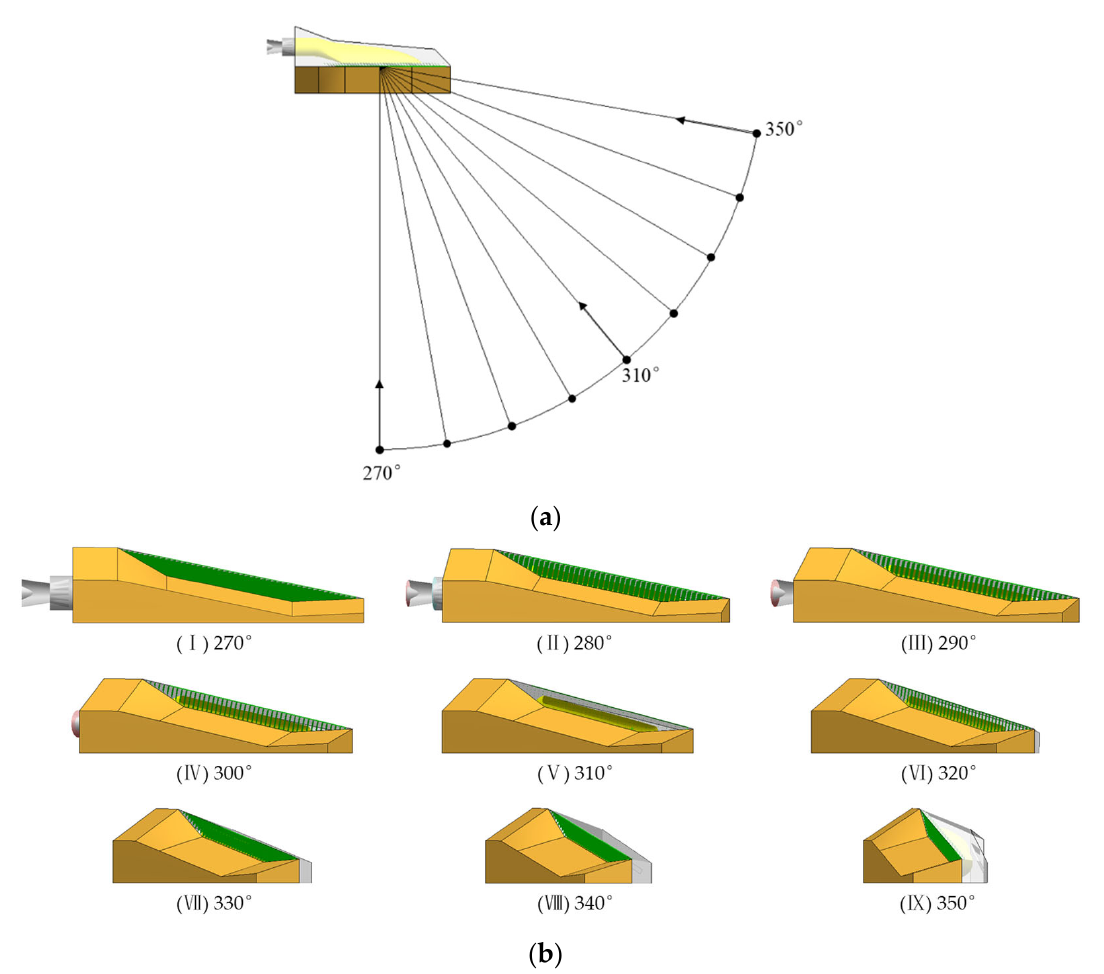
Figure 21. Schematic of shielding e ff ect of de fl ectors on mixing duct. ( a ) De fi nition of detection direction; and ( b ) views from di ff erent detection directions.